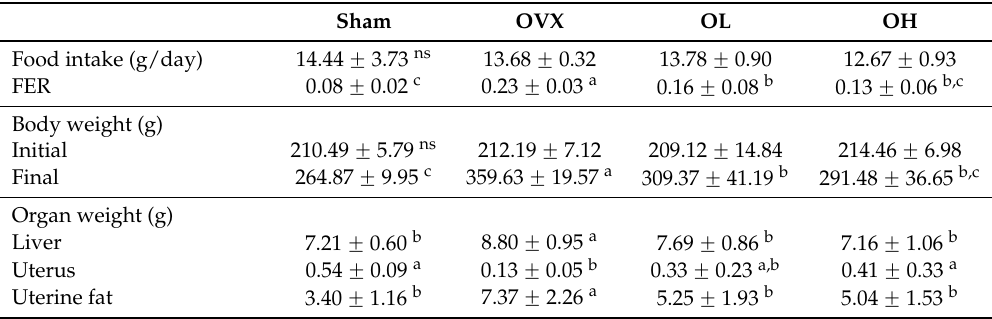
Table 2. Food intake, food efficiency ratio, body weight, and organ weight.